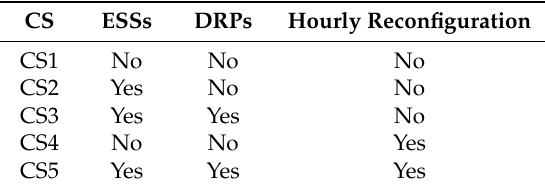
Table 5. Distinguishing the different Case Studies (CSs) (Energy Storage Systems